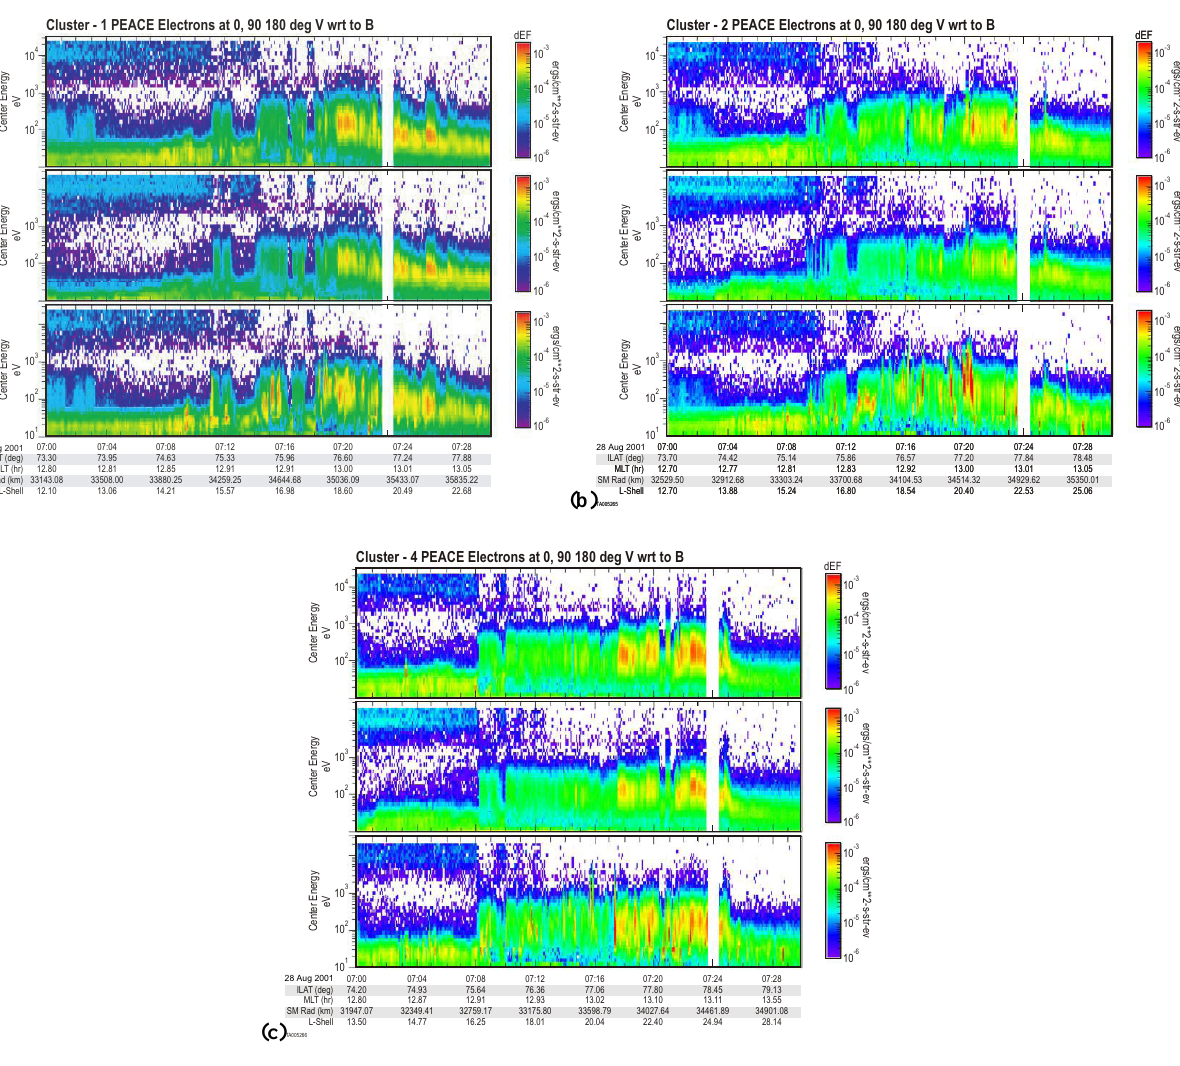
Fig. 6. Cluster C1, C2, and C4 PEACE electron data are displayed in panels (a–c) for the approximate time interval 07:00 UT–07:30 UT. The format for the panels (top to bottom) is energy flux for downward, trapped (90 ◦ pitch angle), and upward electrons.